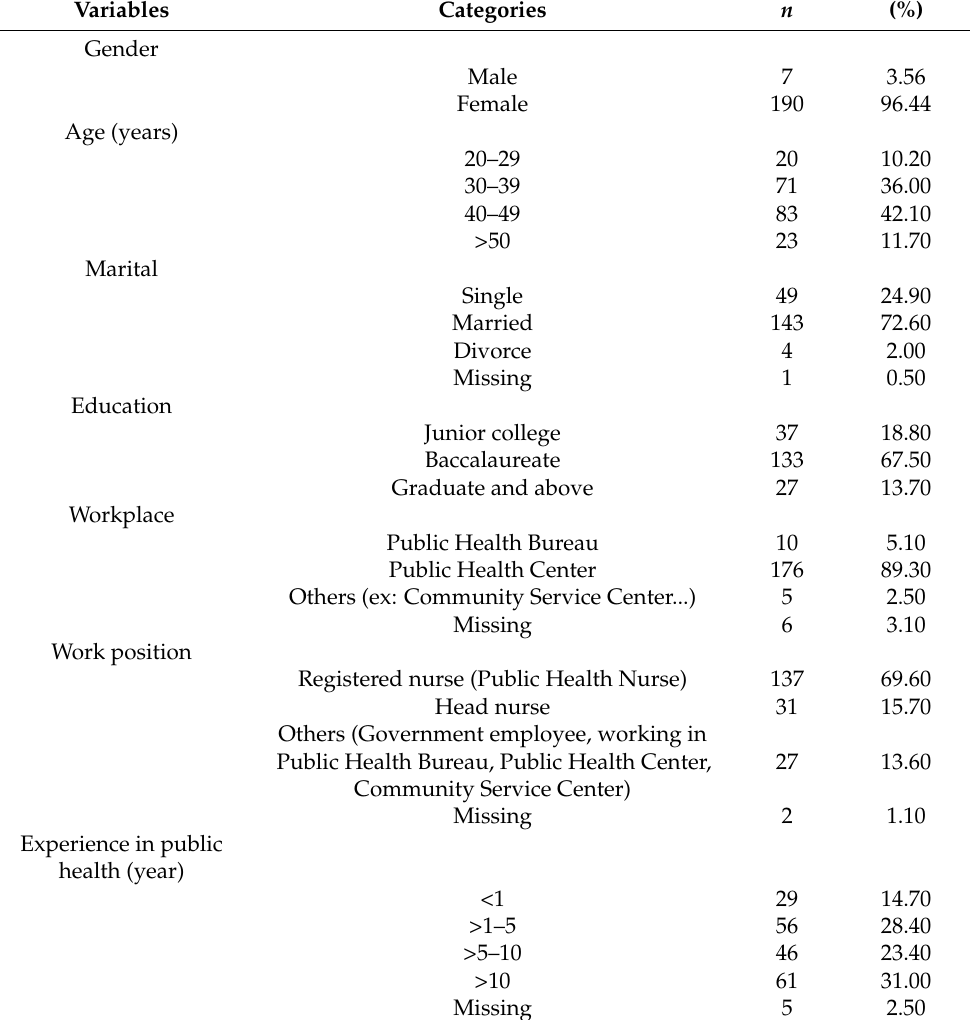
Table 1. Demographic characteristics of the subjects ( n =